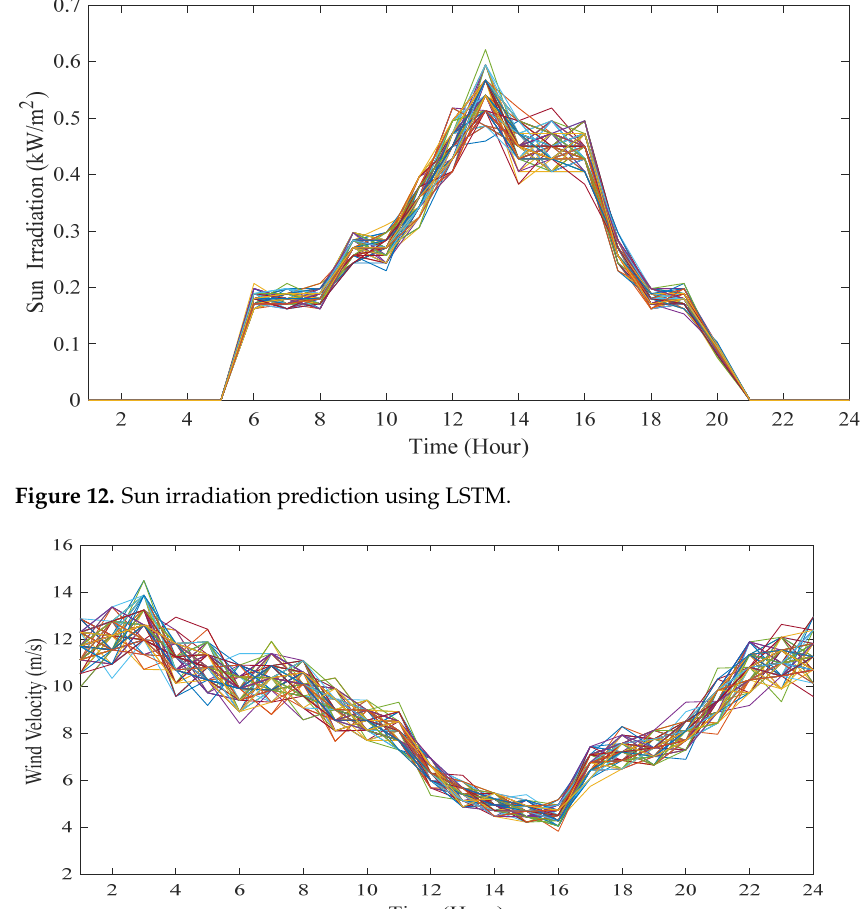
Figure 13. Wind velocity prediction using LSTM.